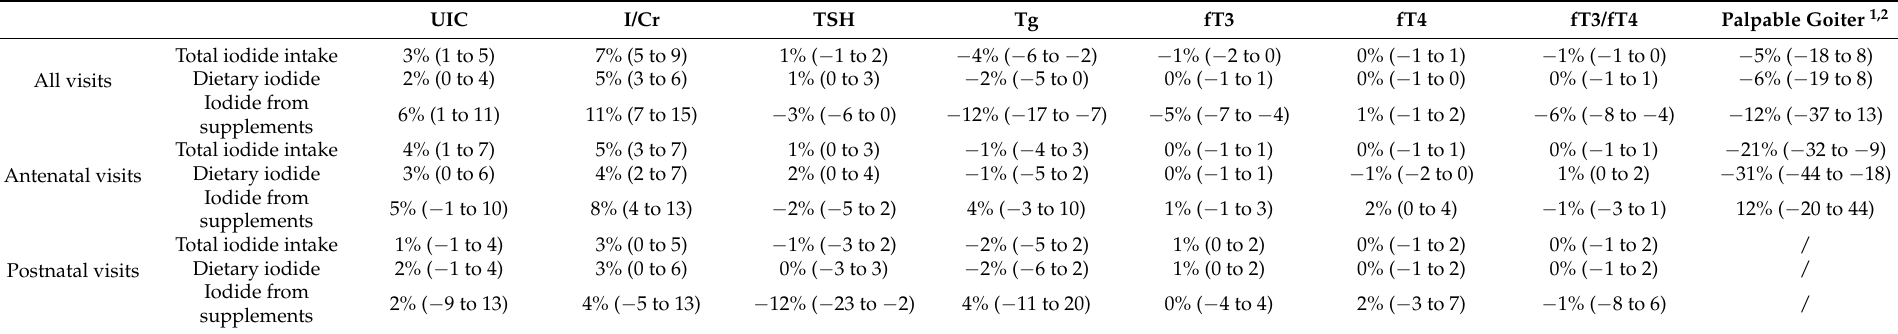
Table 4. Adjusted percent difference (95% CIs) in urinary iodine, thyroid hormone concentrations and goiter rate per 50 µ g increase in iodide